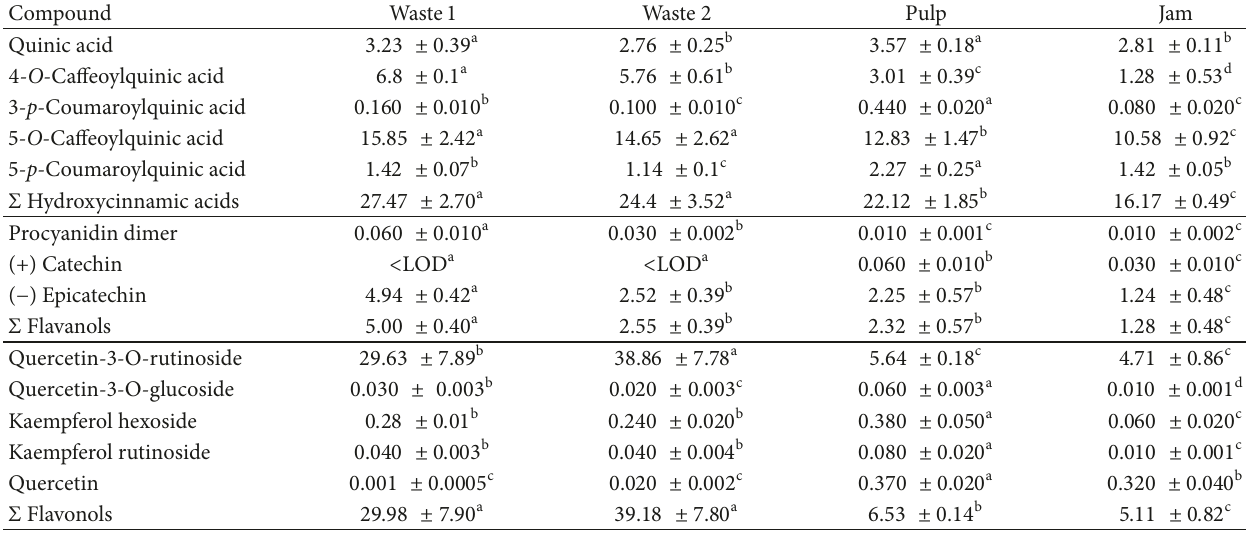
Table 2: Phenolic composition of different samples analyzed (mg/100g fresh